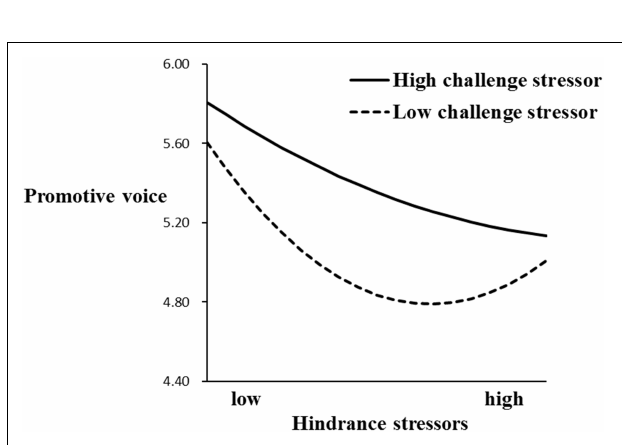
FIGURE 3 | Moderating effect of challenge stressors on the relationship between hindrance stressors and promotive